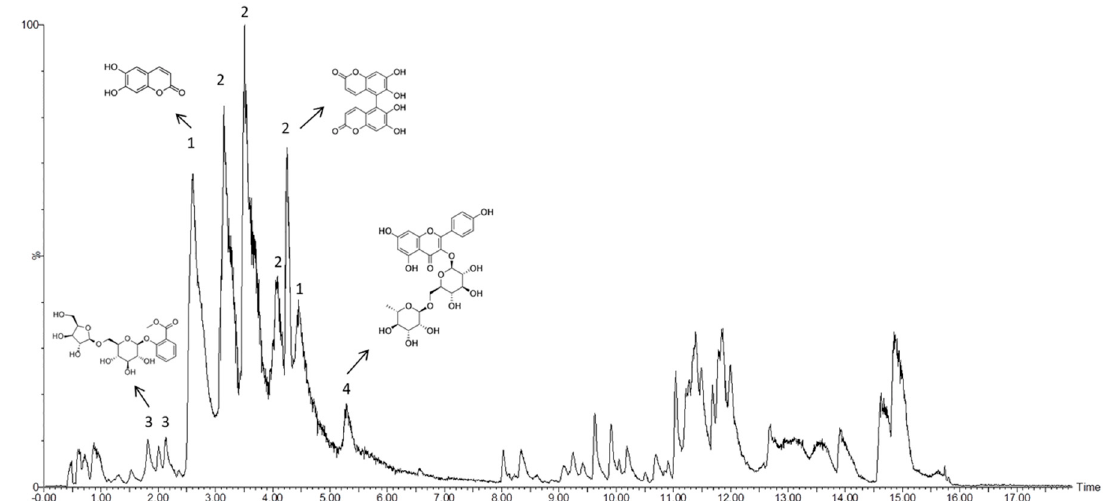
Figure 2. High-performance liquid chromatography chromatogram of polyphenols obtained from the ethanolic extract of Euphorbia lathyris . Peak assignment: 1: Esculetin, 2: Euphorbetin, 3: Gaultherin, 4: Kaempferol-3-rutinoside.